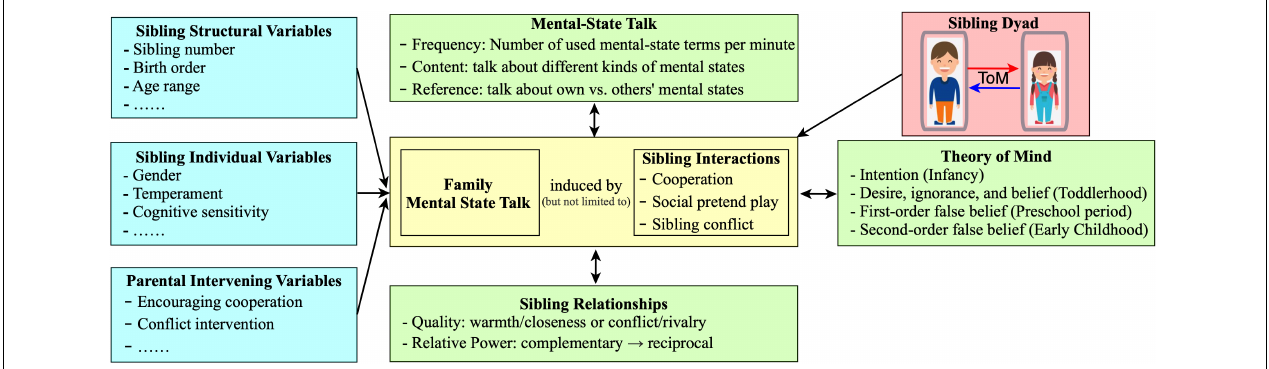
FIGURE 1 | A reciprocal and dynamic development model for sibling–Theory of Mind (ToM) association. Three kinds of sibling–related variables that might affect children’s ToM have been identified (cyan). The mechanism underlying the sibling–ToM link is that having siblings leads to more opportunities for children to be exposed to and take part in family mental-state talk among parents, siblings, and target children, providing unique insights into the workings of the social world. Here, it is worth noting that family mental-state talk could be induced by but not limited to sibling interactions. For example, mental-state talk is also induced by parent–child reading (yellow). On the other hand, this model underlines the reciprocal and divergent influences of older and younger siblings. Specifically, we suspect that older siblings might continuously promote younger children’s ToM development from toddlerhood to childhood of the later-born child. By contrast, there might be an inflection point, where the direction of younger sibling–ToM association transforms from negative (during the first year of the later-born child’s life, parents need to spend more time and effort on infant or toddler caretaking, which poses an obstacle to the development of the ToM ability of older siblings) to positive, when the later-born child is growing into a more skilled playmate from the second year of his/her life (red). On the other hand, given that children’s ToM, the nature of the family mental-state talk, and sibling relationships are all constantly changing with age, this model claims that the sibling–ToM link is a dynamic process but not a static concept (green). This model highlights the interrelations among relationship quality, interactions, and ToM. Specifically, the quality of sibling relationships influences the frequency and quality of sibling interactions; frequent and intense interactions between siblings can shape the development of mindreading abilities and sibling